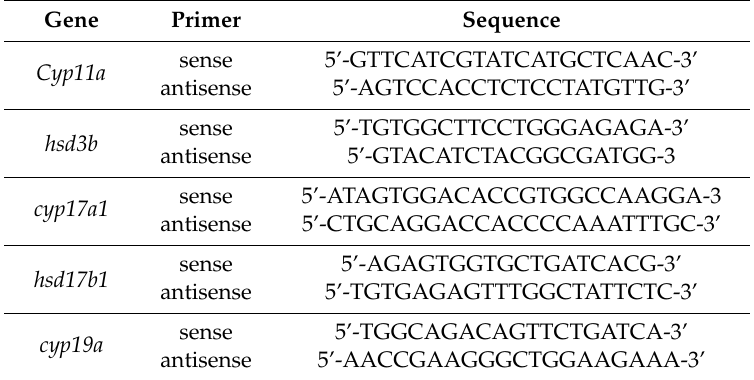
Table 1. PCR primer sequences for amplification of partial cDNAs encoding P450 side-chain